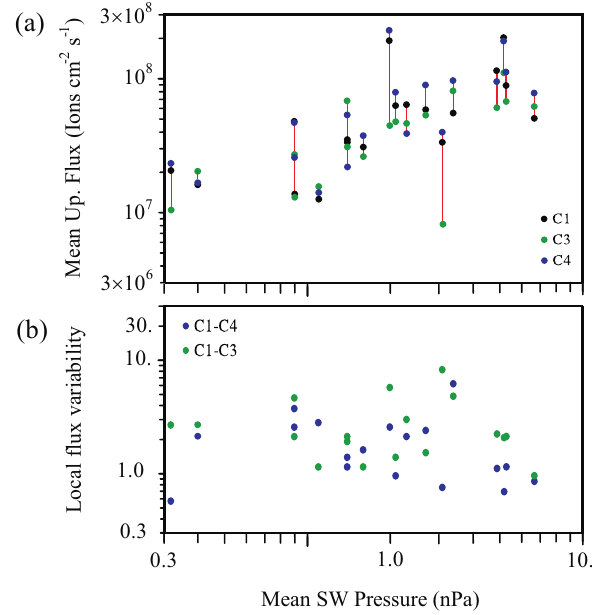
Fig. 8. Scatterplots of (a) the average integral upward fluxes mea- sured on C1 (black), C3 (green) and C4 (blue), and (b) local flux variability between C1 and C4 (blue rounds), and between C1 and C3 (green rounds), as a function of the mean solar wind